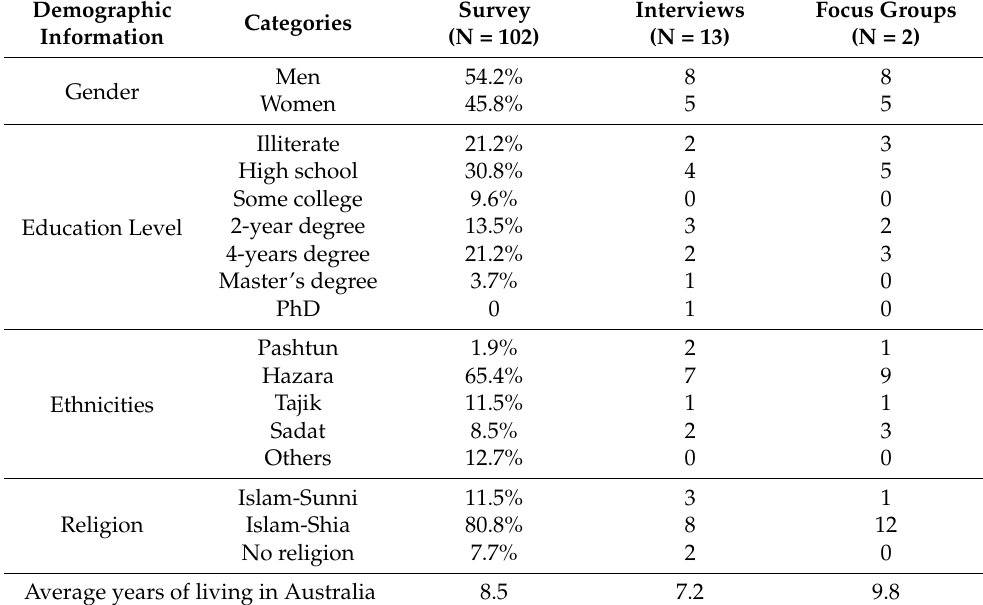
Table 1. Participant demographic